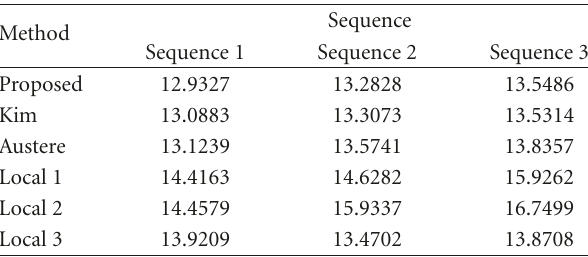
Table 2: Average MSE for test